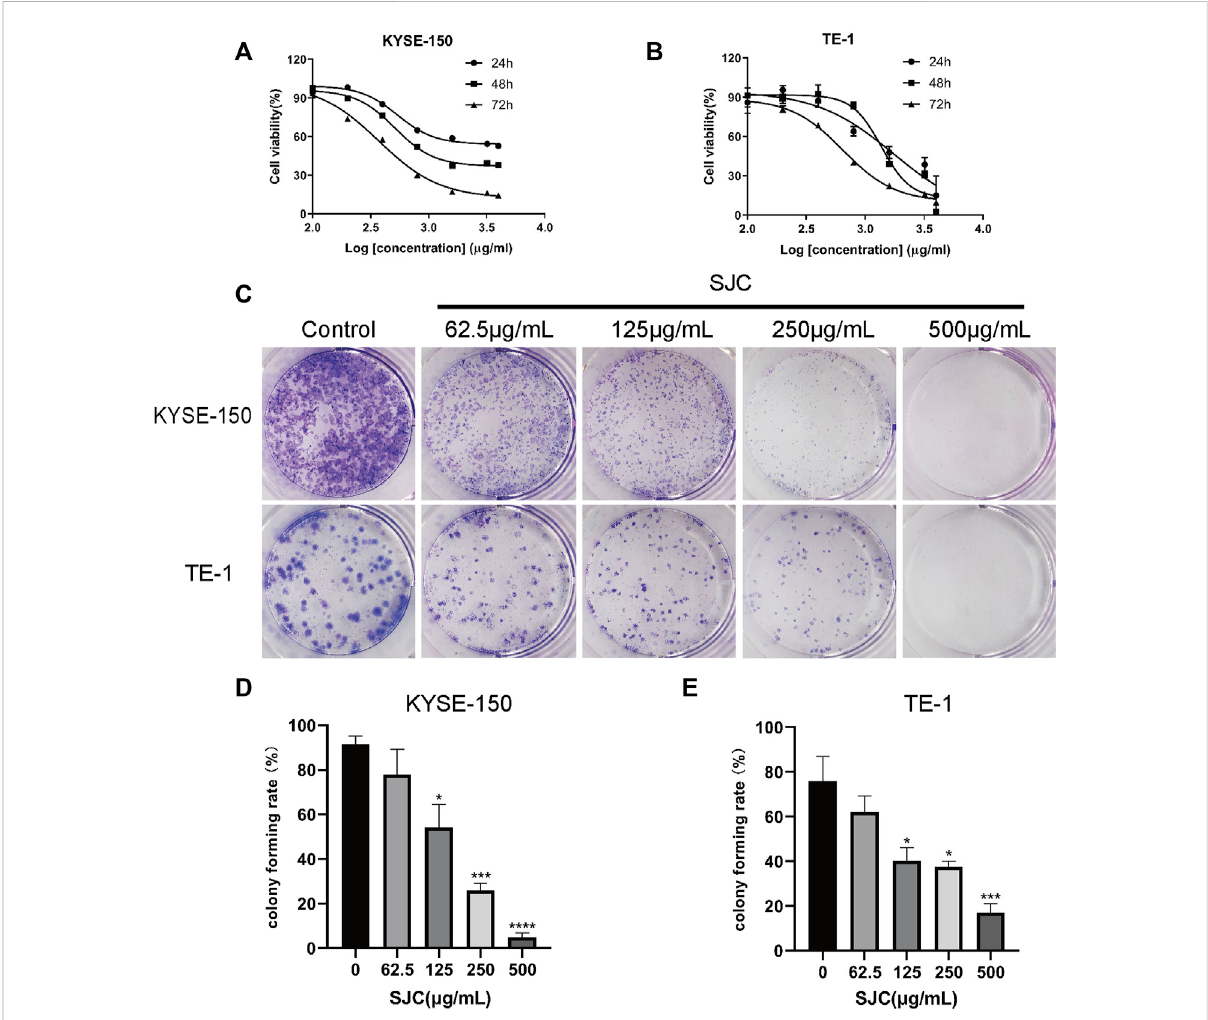
FIGURE 2 The inhibitory effect of SJC on esophageal cancer KYSE-150 cells and TE-1 cells. (A) CCK-8 assay was used to determine the sensitivity of esophageal carcinoma KYSE-150 cells to SJC. (B) CCK-8 assay was used to determine the sensitivity of esophageal carcinoma TE-1 cells to SJC. (C) Clonogenesis assay was used to detect the effect of SJC on the clonogenesis ability of KYSE-150 cells and TE-1 cells. (D) Histogram of quantitative analysis of relative clonal cell numbers of KYSE-150 cells in esophageal carcinoma. (E) Histogram of quantitative analysis of relative clonal cell numbers of TE-1 cells in esophageal carcinoma. Data are shown as mean ± SEM. * p < 0.05, ** p < 0.01, *** p < 0.001, **** p < 0.0001 vs.